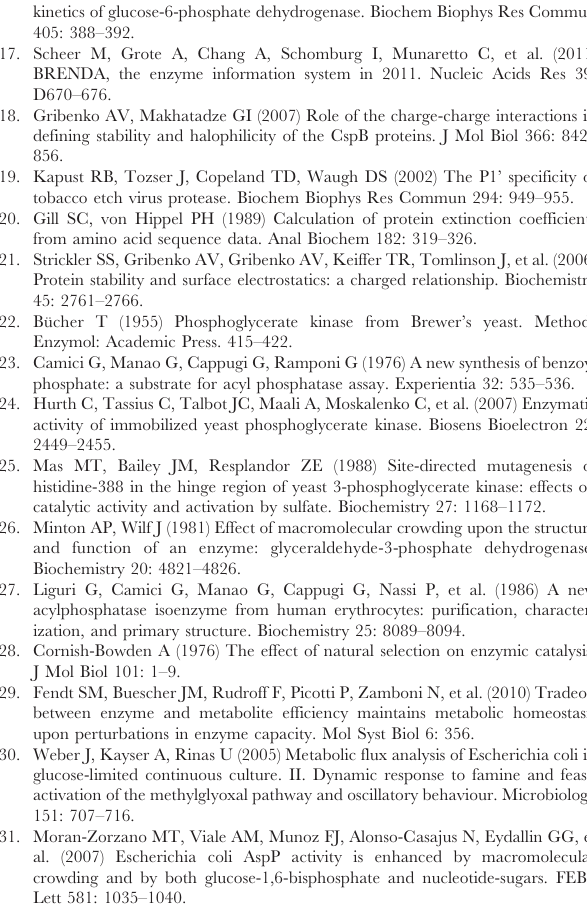
varying concentrations of GAP in the presence of Ficoll. The black lines represent the fit to the Michaelis-Menten equation. The fit results are collated in Table 1. (PDF) Figure S4 Michaelis-Menten plots for ACP with varying concentrations of benzoyl phosphate. ( A ) Michaelis-Menten plot for ACP (10 nM) with varying concentrations of benzoyl phosphate in the absence of Ficoll. ( B ) Michaelis-Menten plot for ACP (10 nM) with varying concentrations of benzoyl phosphate in the presence of Ficoll. The black lines represent the fit to the Michaelis-Menten equation. The fit results are collated in Table 1. (PDF) Table S1 Summary of K m values for PGK from different